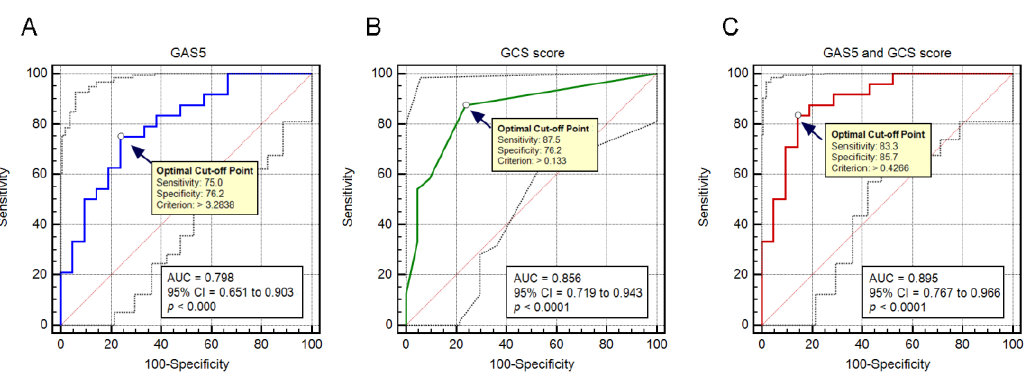
Figure 3. Receiver operating characteristic (ROC) curves of GAS5 ( A ), GCS score ( B ), and the combination of both ( C ), relative to early outcome of TBI patients.